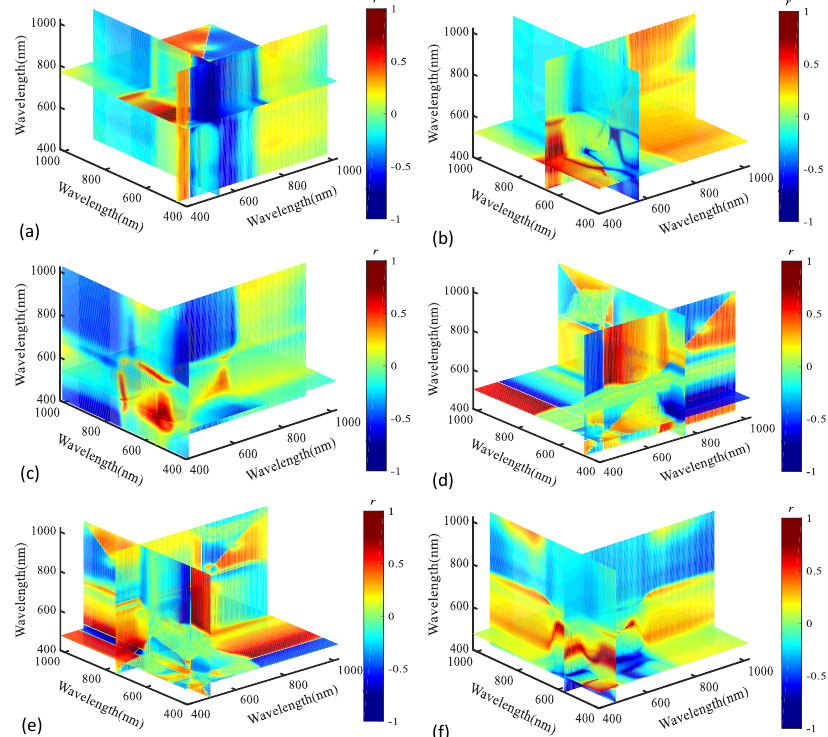
Figure 4. Correlation coefficient between PNC and three-band spectral indices. ( a – f ) three-band spectral index 1- three-band spectral index 6.